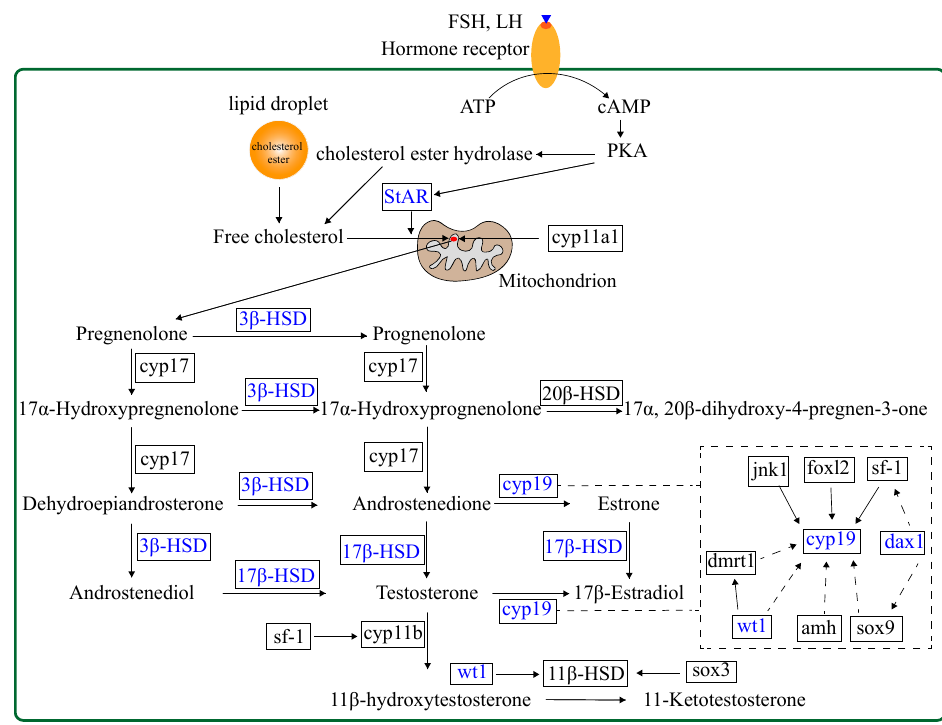
Figure 2. A schematic pathway of steroidogenesis and regulation of steroidogenic enzyme genes with its transcription factors in the gonads of teleost [22,32]. Words in blue represent genes that are upregulated or downregulated by miR-430 in rice field eel.